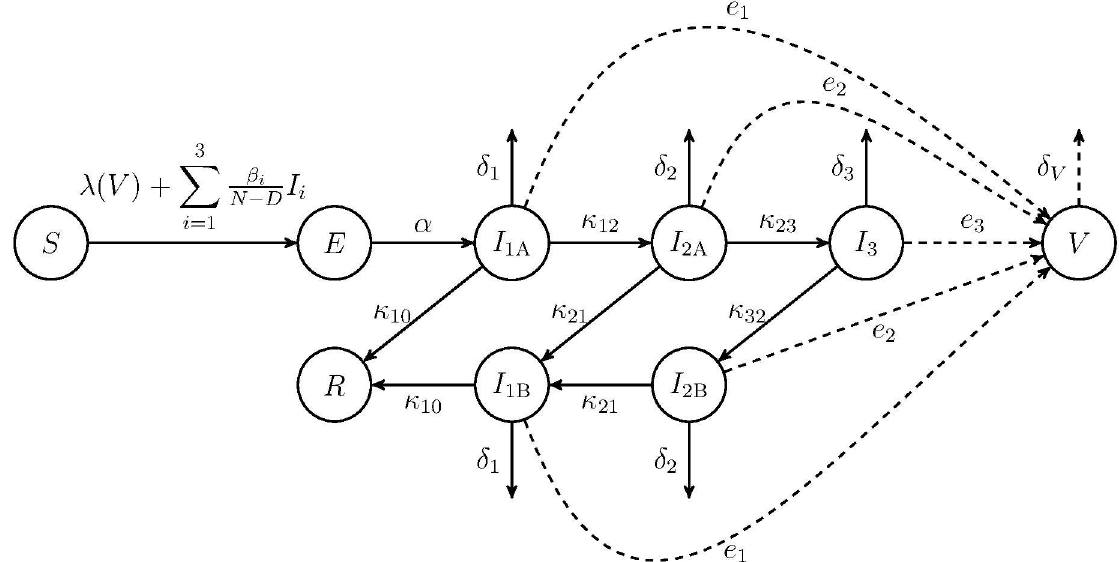
Fig 1. Basic viral titer compartment transmission model schematic with three infection classes. The rates of transfer betweenthe classes are indicated,where I 1 = I 1A + I 1B and I 2 = I 2A + I 2B .